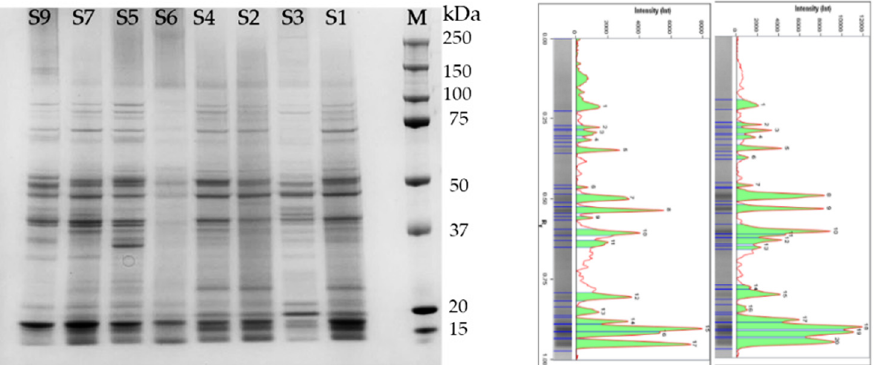
Figure 2. The 1D proteomics analysis of Arthrospira spp. soluble fractions from commercial samples. Proteins (3 µg) were separated using SDS-PAGE (12%) and stained with Coomassie ® Brilliant Blue R-250. Left: representative gel; lanes 1–8: soluble extracts of samples S1, S2, S3, S4, S5, S6, S7 and S9; lane 10 (M): molecular mass marker (Precision Plus Protein Standard, Biorad); right: representative pherograms obtained from samples S4 and S2.